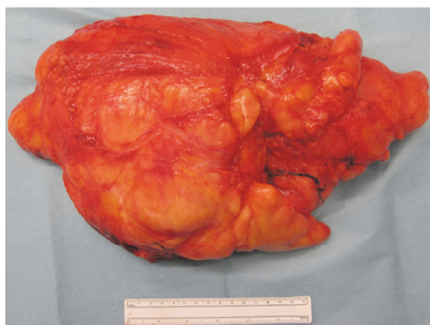
Figure 2: Macroscopic appearance of the resected tumor. The mass includes the semitendinosus muscle, semimembranosus muscle, and biceps femoris muscle.